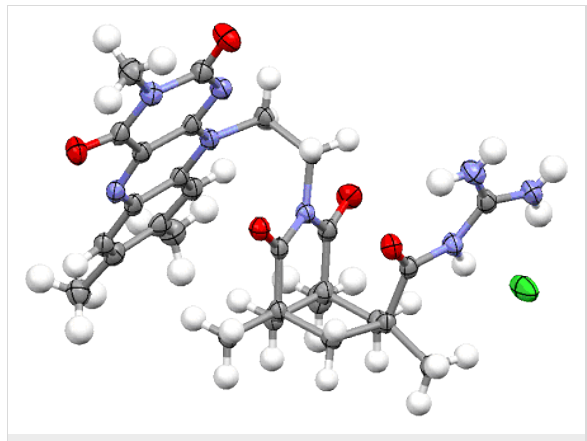
Figure 2: Structure of compound 1 in the solid state. 2-D NMR spectra of compounds 1 and 2 revealed several NOE contacts, but the flexibility of the molecule did not allow the determination of preferred conformations.